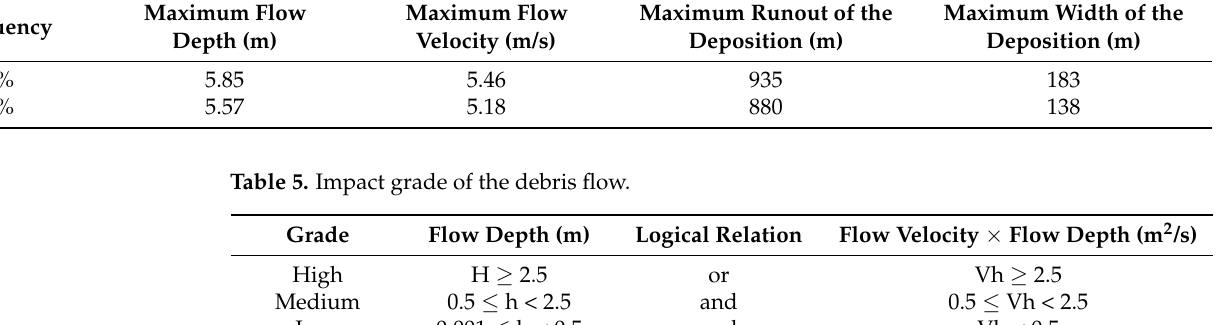
Table 5. Impact grade of the debris flow.